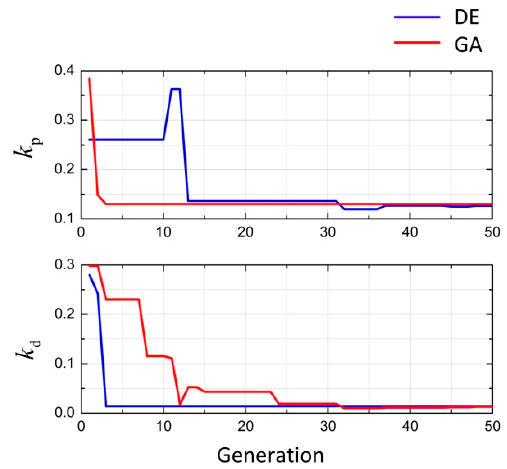
Figure 12. Optimization process of k p and k d in the positioning experiment.